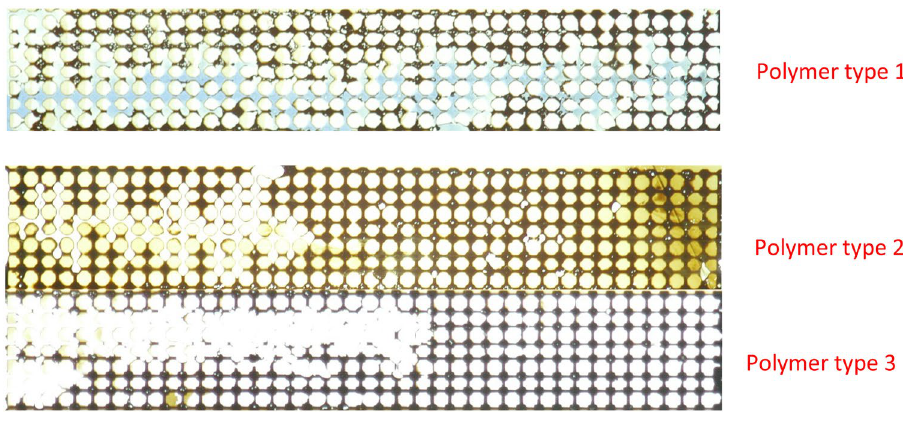
Fig. 9 Comparison between displacement of polymer type 1, 2 and 3 at fixed concentration of 1500 ppm (identical pore volume